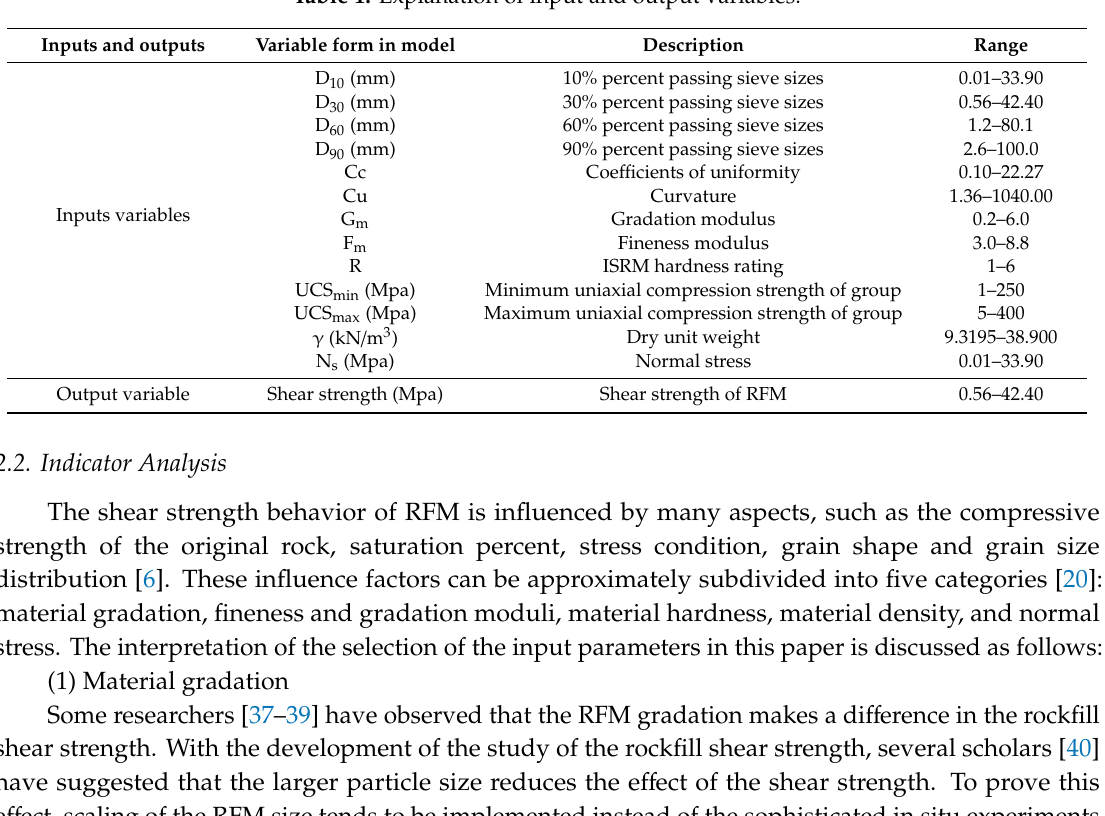
Table 1. Explanation of input and output